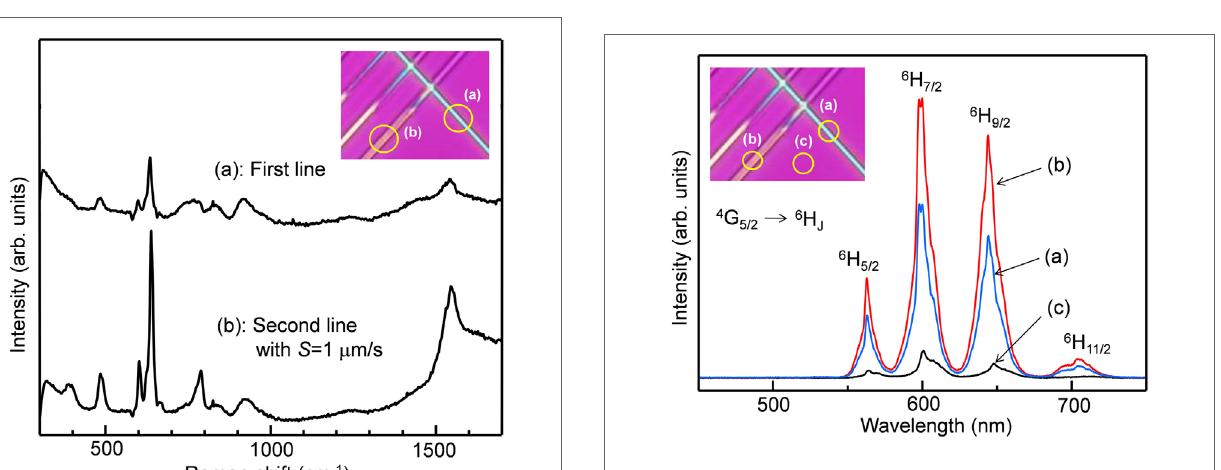
FigUre 6 | Micro-photoluminescence (Pl) spectra at room temperature for the first (a) and second (B) lines patterned by laser irradiation . The PL spectrum for the glassy part (c) (not laser-irradiated part) is also shown.